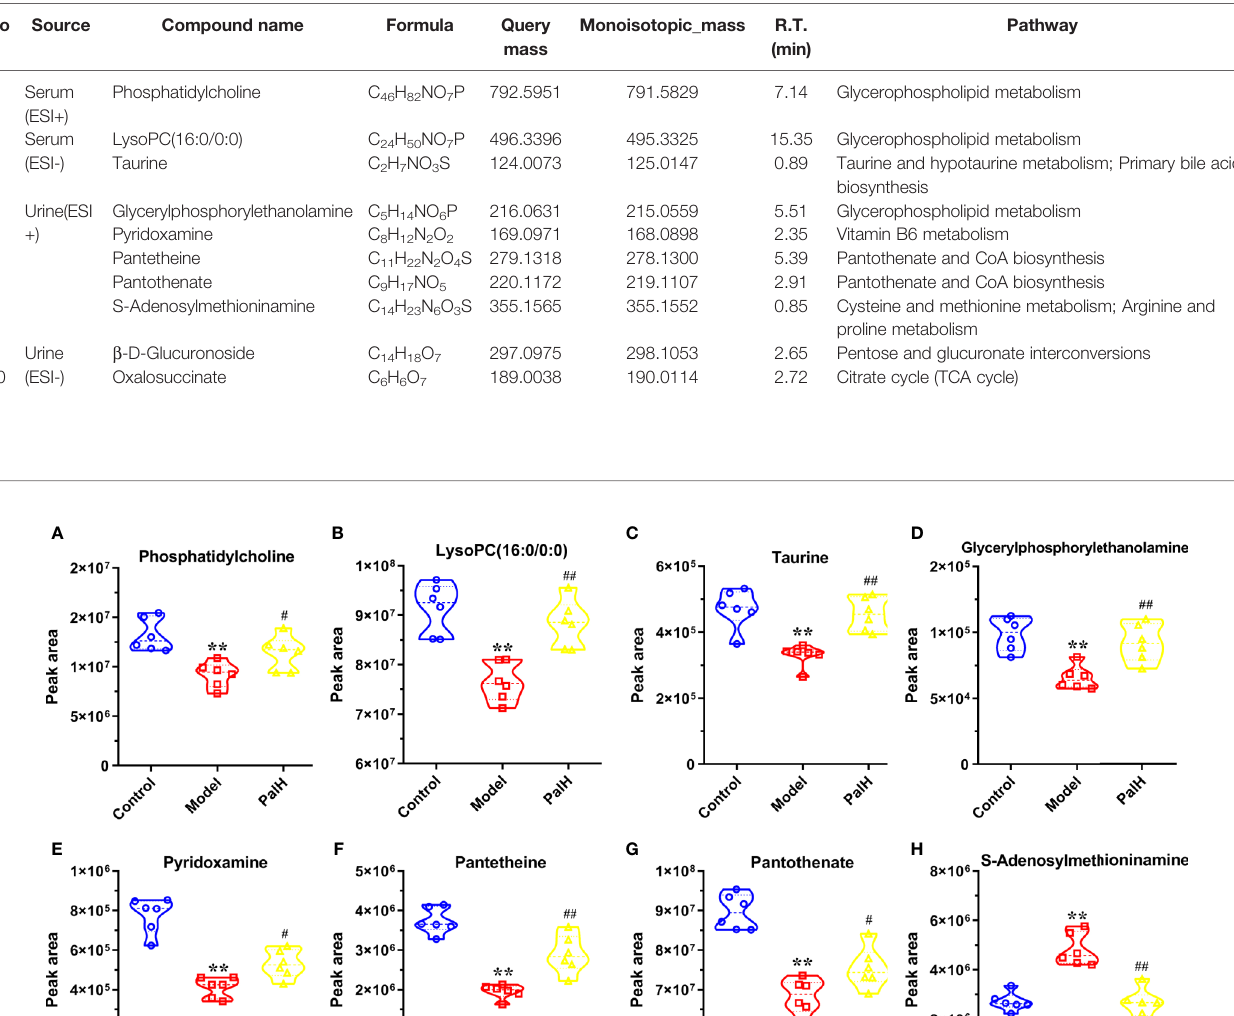
TABLE 3 | Identi fi ed metabolites of serum and urine.